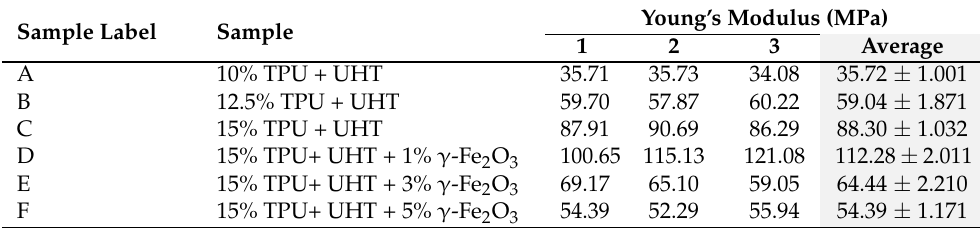
Table 1. Young’s Modulus of scaffolds at different concentrations with and without γ -Fe 2 O 3 . Sample